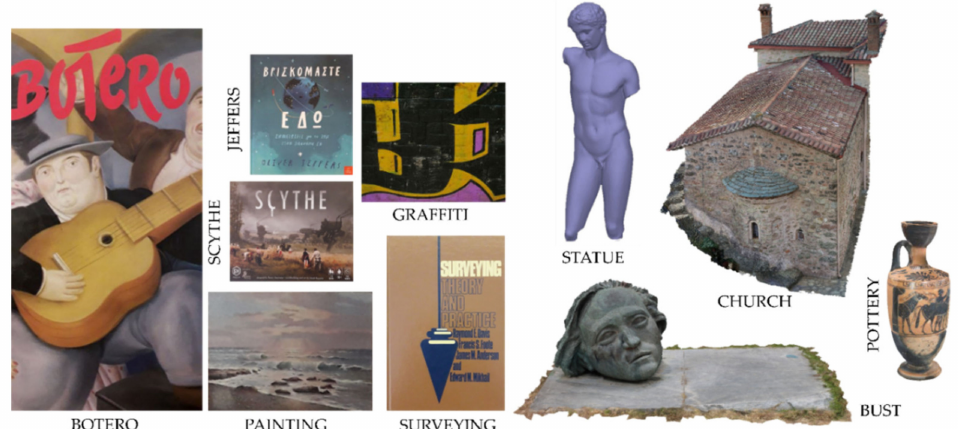
Figure 4. Default pattern images (depicted with correct relative size) and 3D models stored by the ModAR prototype.